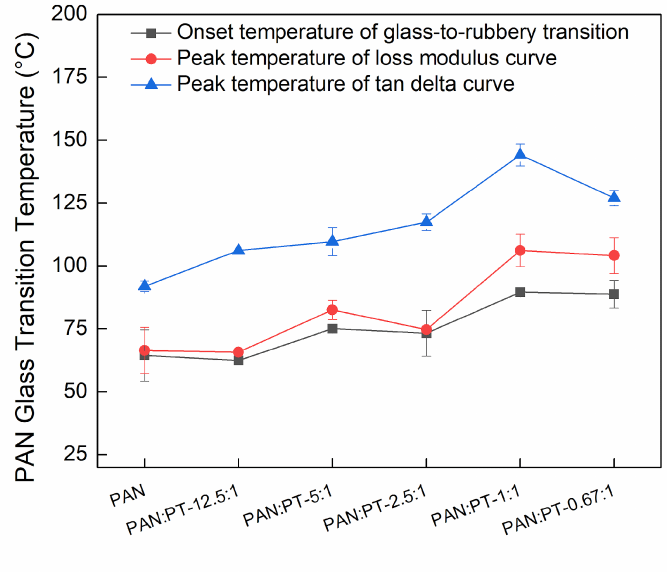
Figure 12. Glass transition temperatures measured from tan δ curves. Three specimens were tested to obtain the average, except for PAN:PT-12.5:1 due to limited